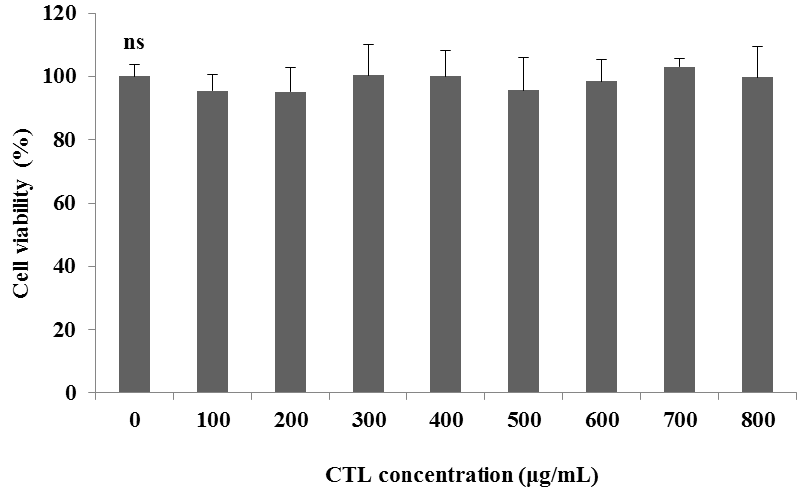
Figure 1. High-performance liquid chromatography (HPLC) analysis of kaempferol in Cudrania tricuspidata leaves (CTL).